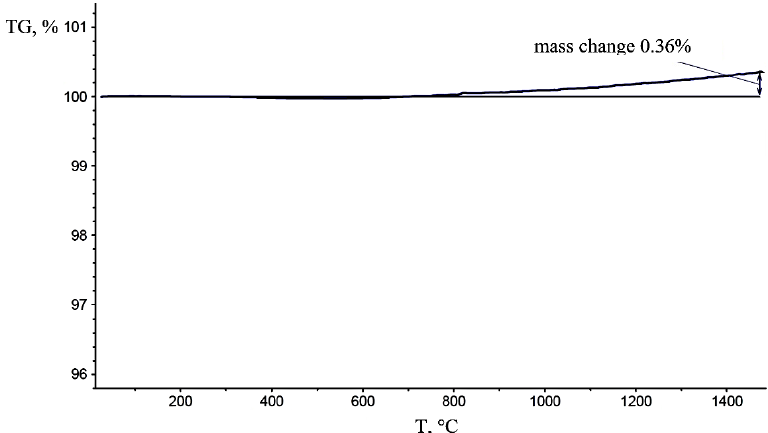
Figure 4. Change in the mass of the “M” composites